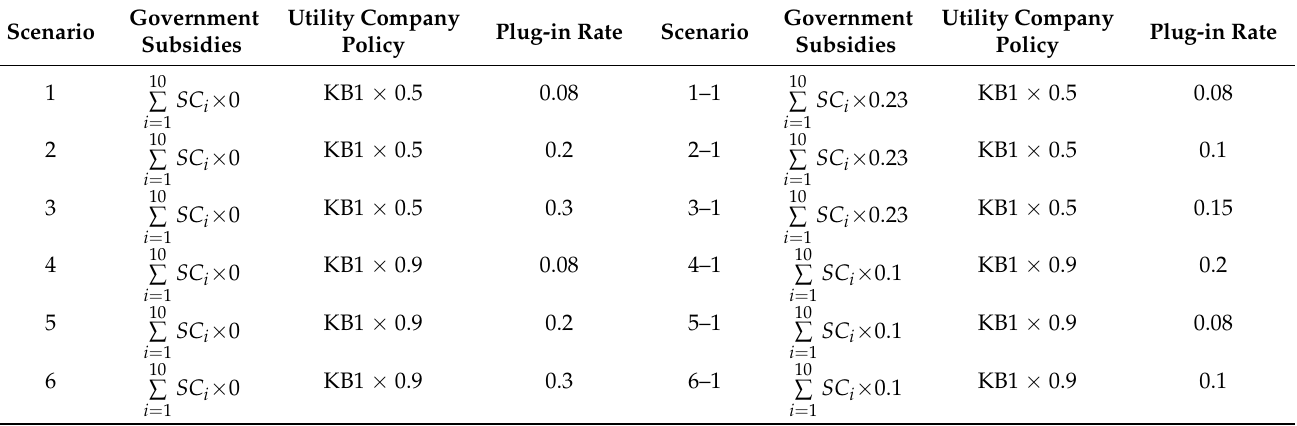
Table 5. Scenarios for